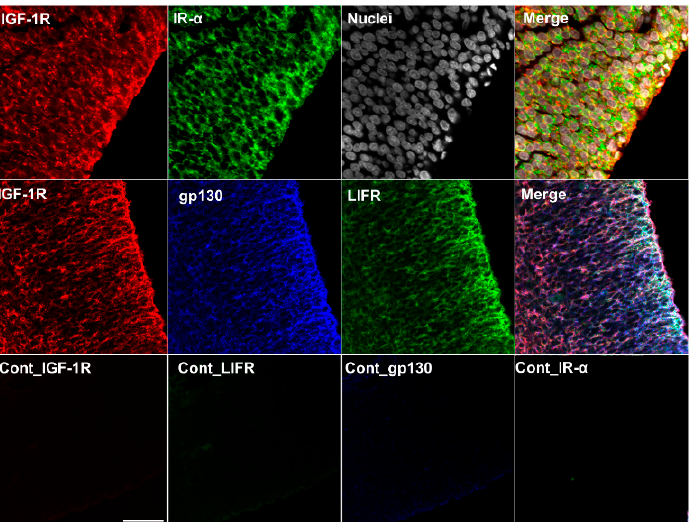
Figure 6. Localization of IGF-1R, IR- α , LIFR, and gp130 in the fetal dorsal cerebrum at E15.5. The localization of IGF-1R is denoted in red, IR- α in green, and their synthesis in yellow (upper raw). Strong staining intensity of IGF-1R (red), gp130 (blue), and LIFR (green) was observed along the apical (ventricular) side of the ventricular zone. The co-localization of these three receptors is demonstrated in white (merge, middle raw). The nuclei were stained with Hoechst 33342 (gray). Cont: negative controls stained with non-immunized rabbit IgG. Scale bar: 25 µm.